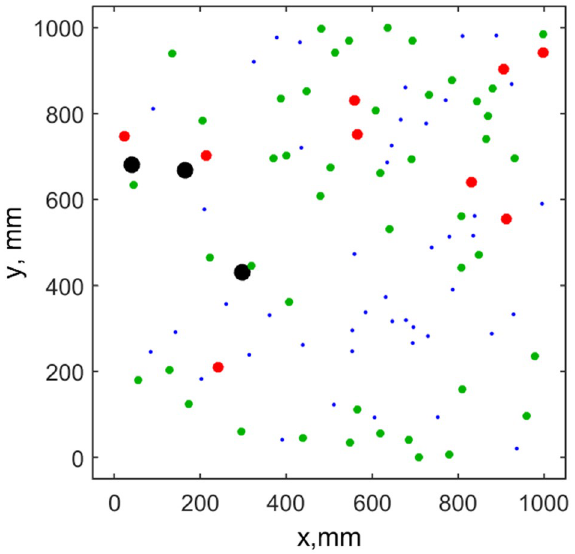
Figure 1. Typical spatial pattern formed by the population at intermediate stage of evolution. Blue, green and red circles correspond to the small medium and large sizes of the individuals. One can see the groups packed by the individuals with the distances close to the equilibrium R min remaining to the current